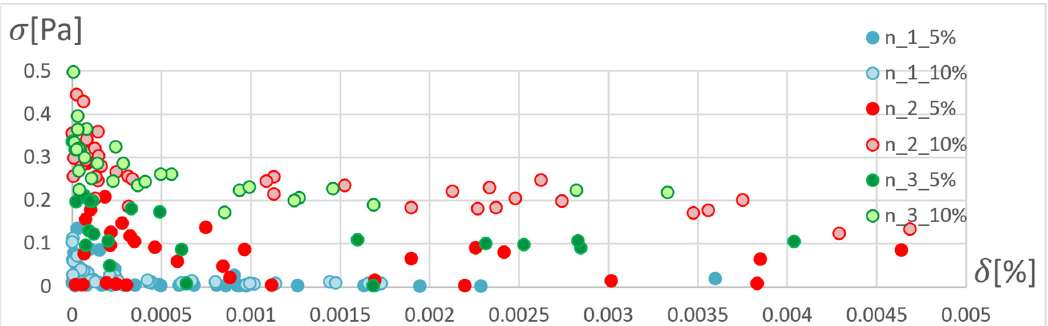
Figure 16. Pareto front for all studied networks trained using the RPROP algorithm.